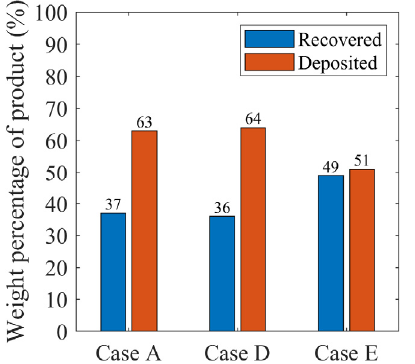
Table 5. Particle mean diameter and mean residence time at outlet .